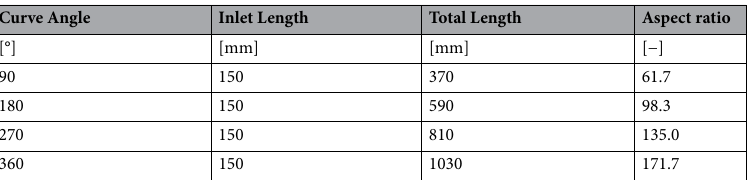
Table 1. Overview of borosilicate glass capillary samples. They all have an inner diameter of 6 mm, an outer diameter of 10 mm and a curve radius of 140 mm.